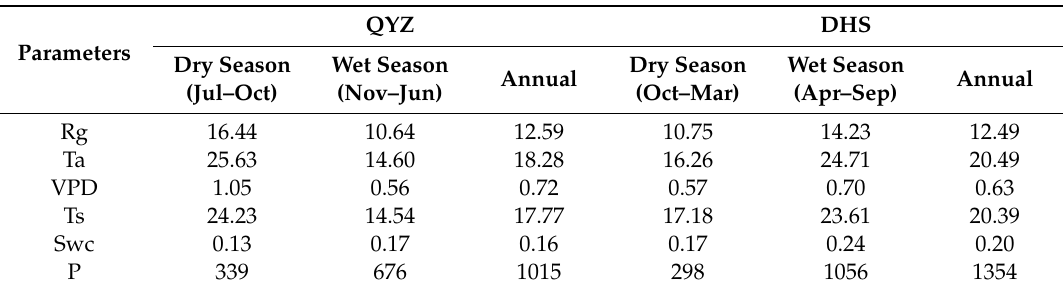
Table 2. Mean air temperature (Ta, ◦ C), vapor pressure deficit (VPD, kPa), 5 cm soil temperature at (Ts,